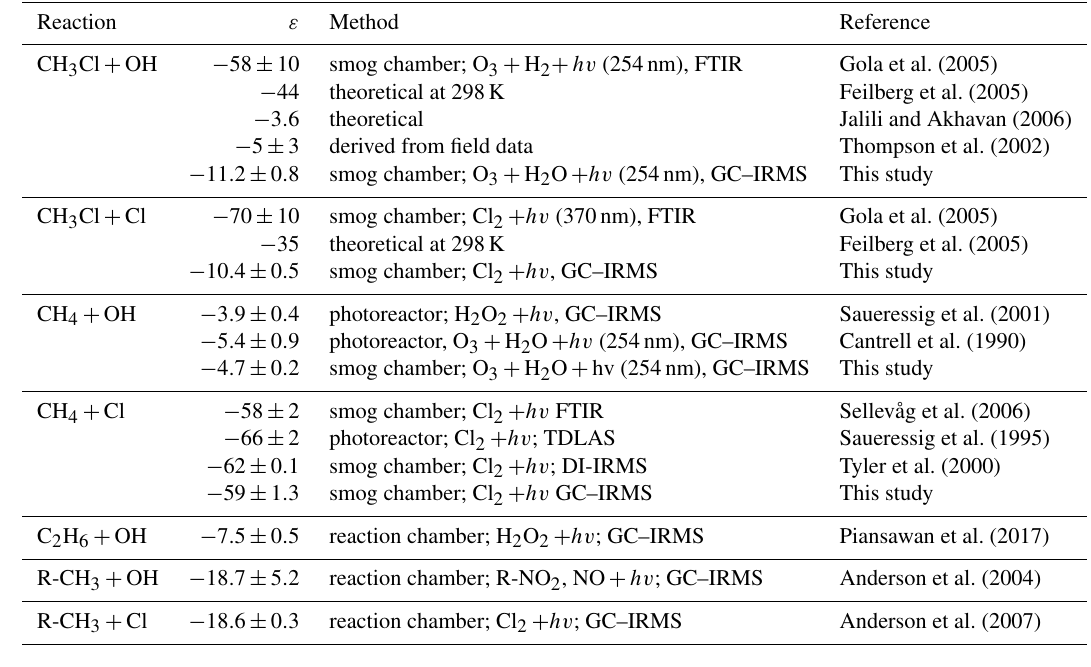
Table 3. Compilation of kinetic isotope effects ( ε ) for the reaction of CH 3 Cl, CH 4 and alkanes with OH and Cl.